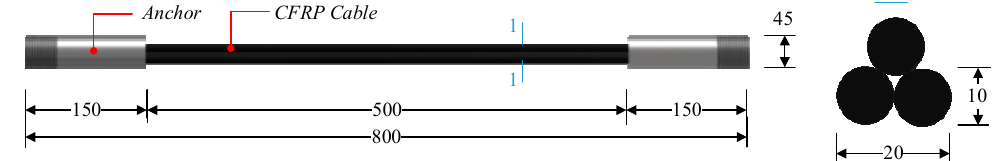
Figure 4. Test pieces of CFRP cable (in mm).